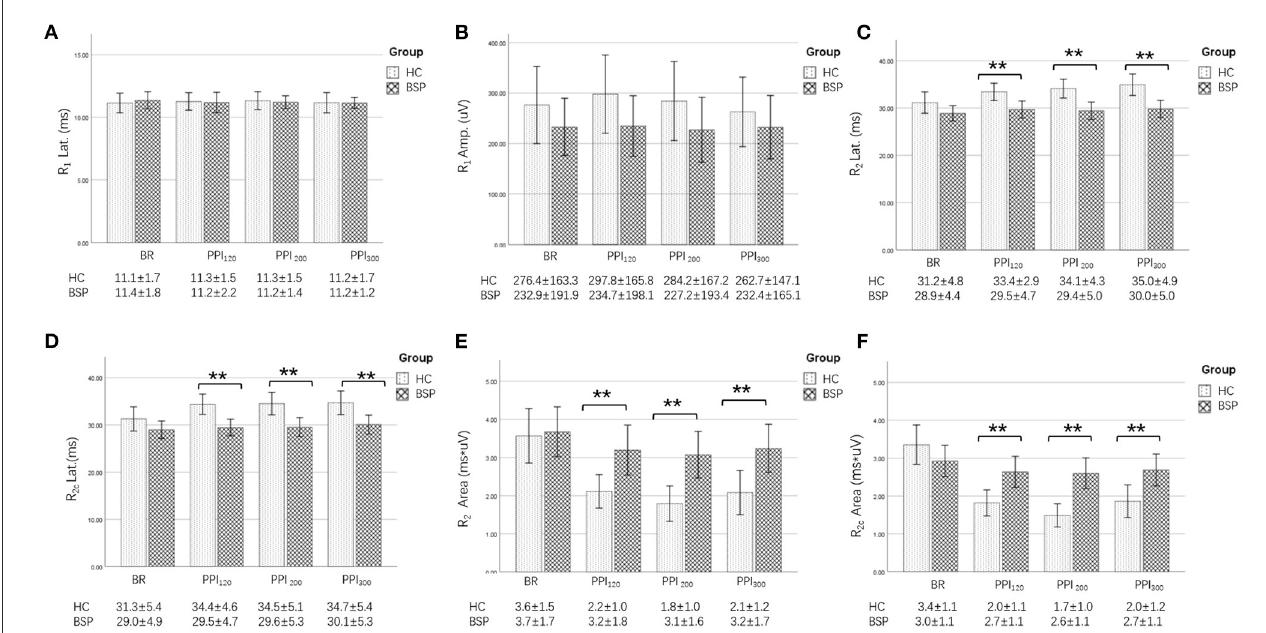
FIGURE2 Comparison of blink-reflex neurophysiological data between the HC and the BSP groups. BR, baseline blink reflex (without a prepulse stimulus); PPI 120 , prepulse inhibition at ISIs of 120ms; PPI 200 , prepulse inhibition at ISIs of 200ms; PPI 300 , prepulse inhibition at ISIs of 300ms. (A) Differences in the R 1 latency between the BSP and HC groups at baseline and prepulse trials administered at different ISIs. (B) Differences in the R 1 amplitude between the BSP and HC groups at baseline and prepulse trials administered at different ISIs. (C) Differences in the R 2 latency between the BSP and HC groups at baseline and prepulse trials administered at different ISIs. (D) Differences in the R 2c latency between the BSP and HC groups at baseline and prepulse trials administered at different ISIs. (E) Differences in the R 2 area between the BSP and HC groups at baseline and prepulse trials delivered at different ISIs. (F) Differences in the R 2c area between the BSP and HC groups at baseline and prepulse trials delivered at different ISIs. Non-normally distributed and qualitative data were analyzed using the Mann-Whitney U -test, and normally distributed data were analyzed using the independent-sample t -test. ** p <